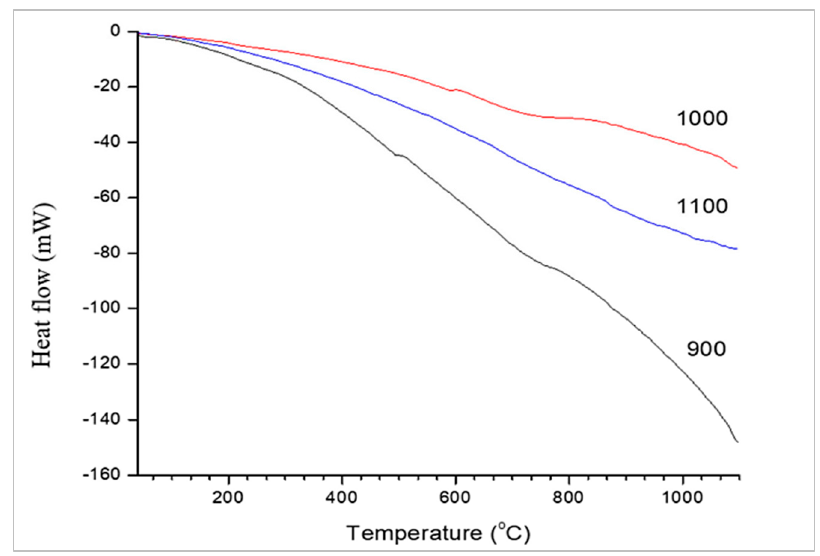
Figure 24. Differential scanning calorimetry (DSC) [107].